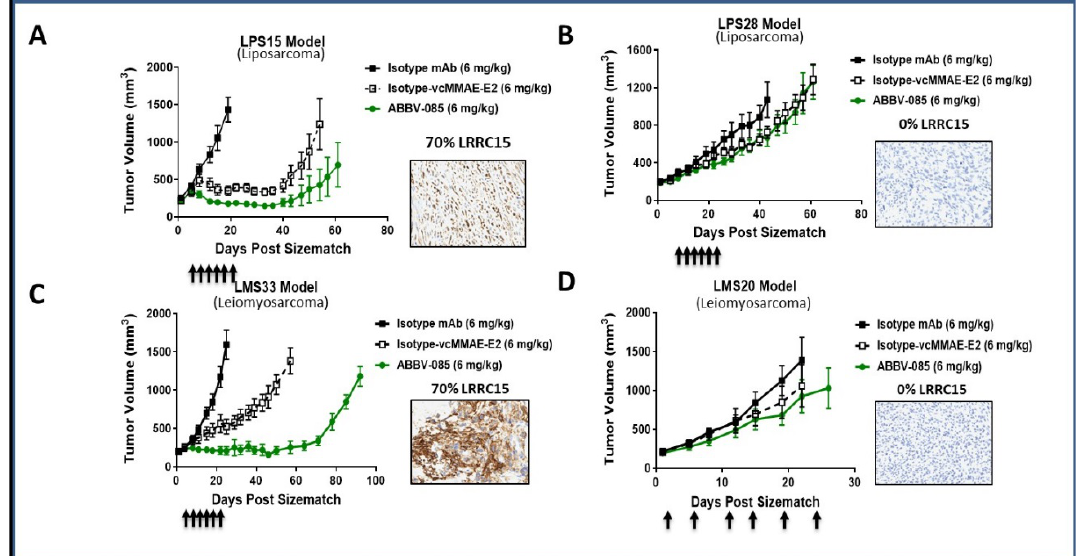
Figure 3. In vivo anti-tumor activity of ABBV-085 monotherapy in STS. ( A , B ) Tumor growth curves for liposarcoma models LPS15 (A: LRRC15 positive) and LPS28 (B: LRRC15 negative) treated with ABBV-085. ( B ) Tumor growth curves for leiomyosarcoma models LMS33 ( C : LRRC15 cancer positive) and LMS20 ( D : LRRC15 negative) treated with ABBV-085. A total of 7–9 mice/group of treatment. For each model, a figure indicating the level LRRC15 expression in the parental tumor from which the patient-derived xenograft (PDX) was derived is represented.